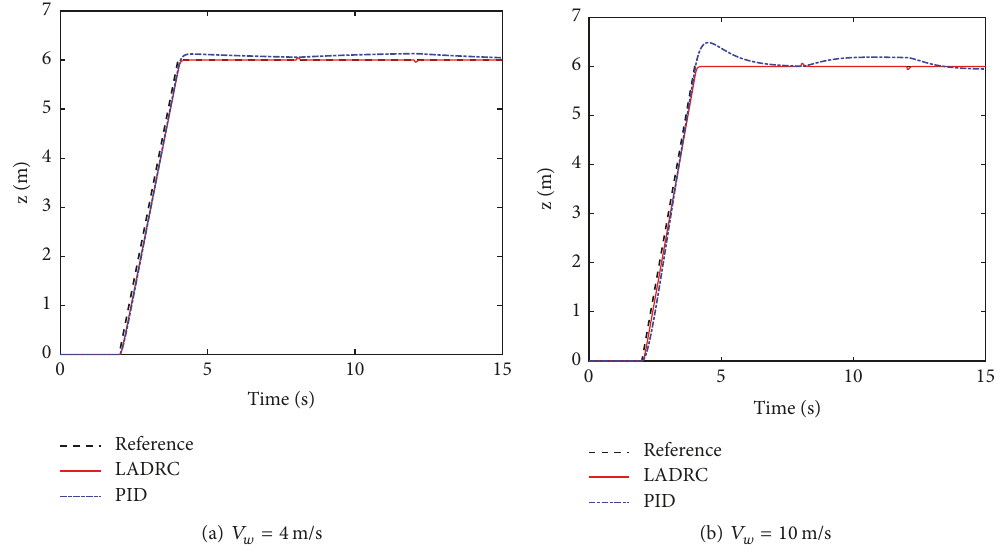
Figure 7: Position response under different wind gusts.